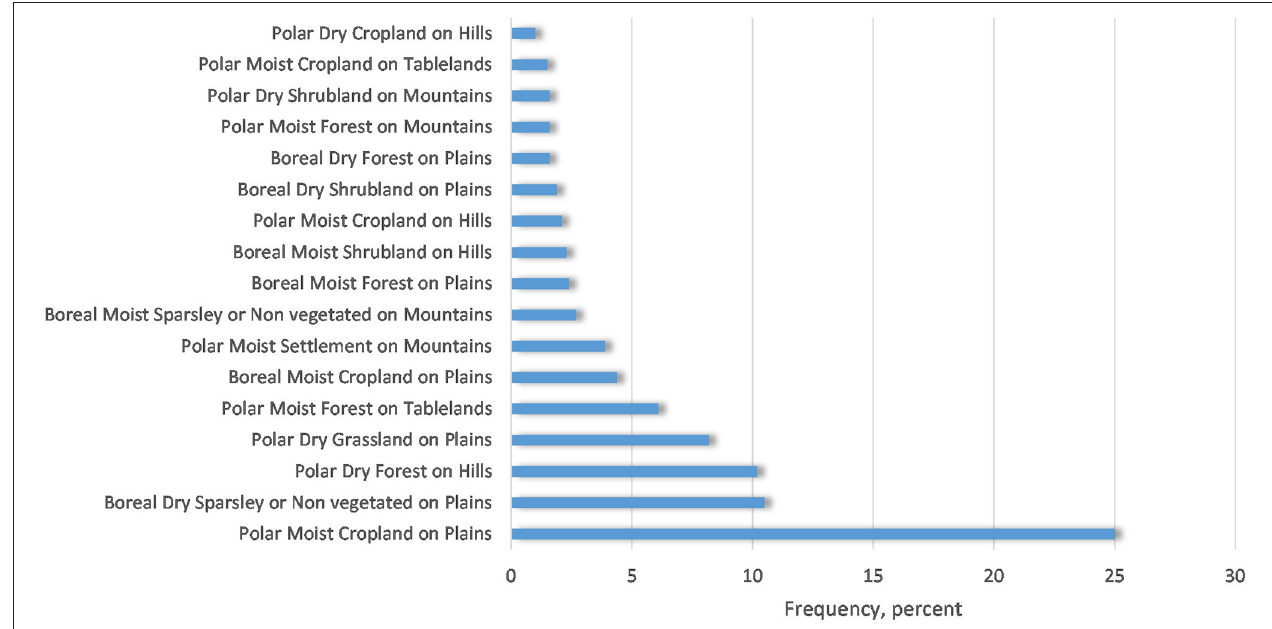
FIGURE 3 | Distribution of the leptospirosis cases in relation to ecosystems.